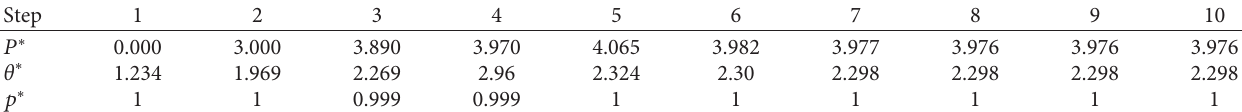
� 0 . 1 , λ � 0 . 5 , λ � 0 . 6 , β � 0 . 8 , β � 0 . 4 , c � 0 . 5 , and δ � 0 . 2 0 1 1 2